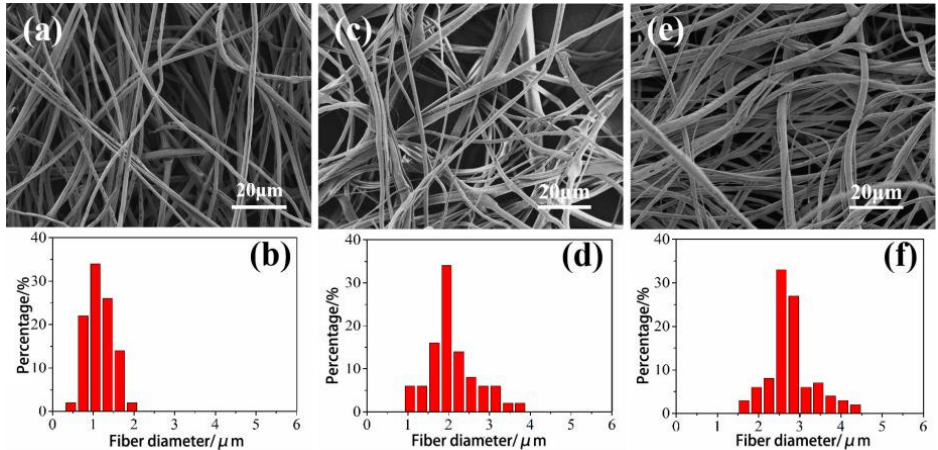
Figure 7. SEM images and fiber diameter distribution diagrams of CA fibers spun with different spinning head apertures. ( a , b ): 0.3mm; ( c , d ): 0.4 mm; ( e , f ): 0.5